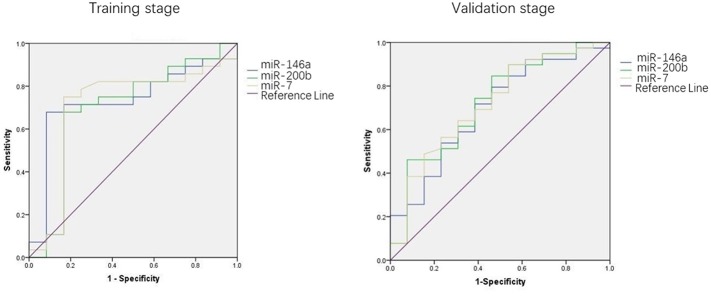
ROC curves of three miRNAs.